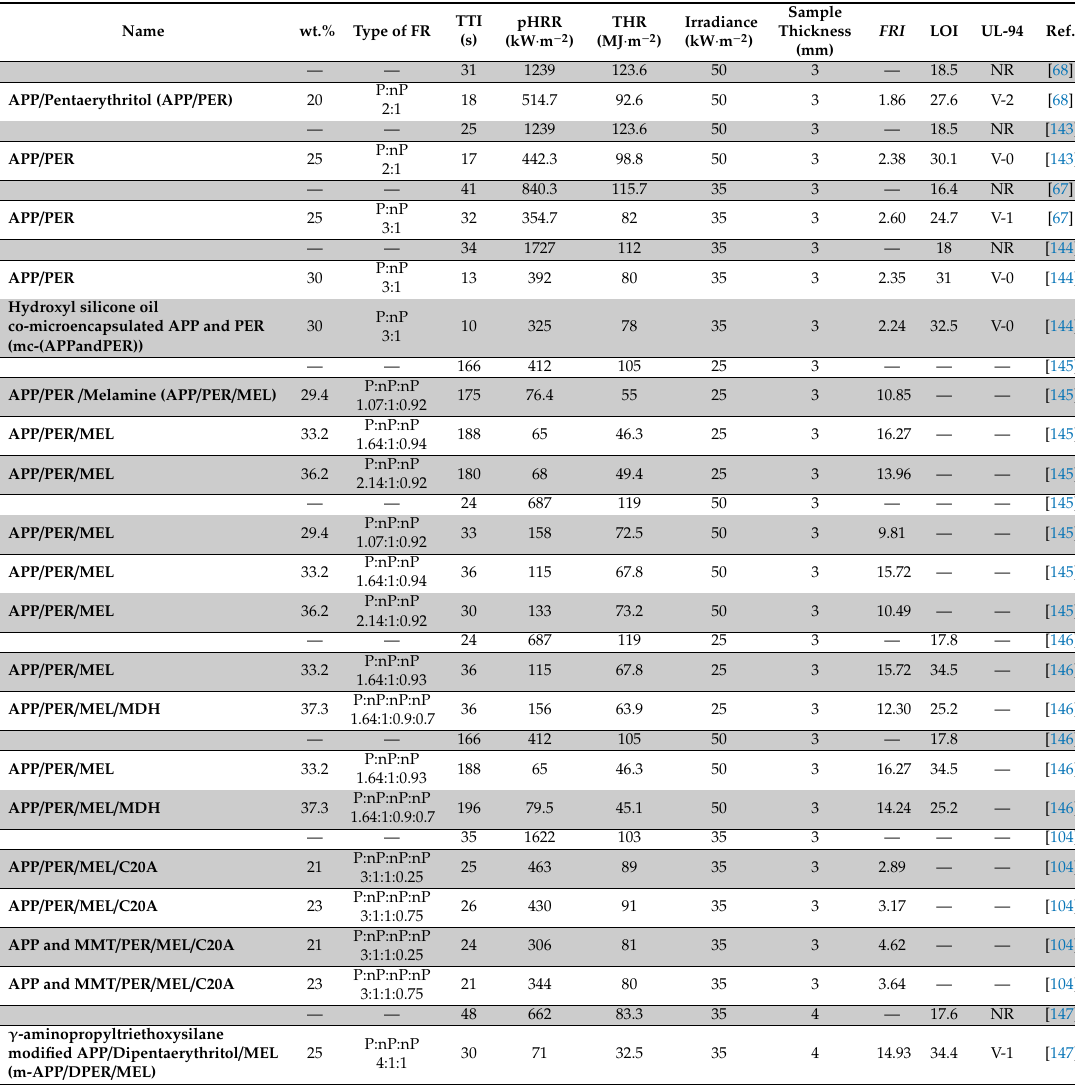
Table 6. The flame retardancy performance of PP containing various combinations of flame retardants in terms of FRI (* the name and percentage of incorporated flame retardants are given after PP). P = phosphorus FR, Np = non-phosphorus FR, N = nitrogen FR, nN = non-nitrogen-based FR, M = mineralFR,Bio = bio-basedFR,nBio = nonbio-basedFR(onecanalsoconsidersomenitrogen-based FRs containing phosphorus element as the combination of phosphorus and nitrogen resulting in synergism, Table 2). Since all comparisons were made in terms of FRI , classification of polymers in terms of their flame-retardant properties was not surveyed based on the chemistry of additives, heat flux, sample thickness,